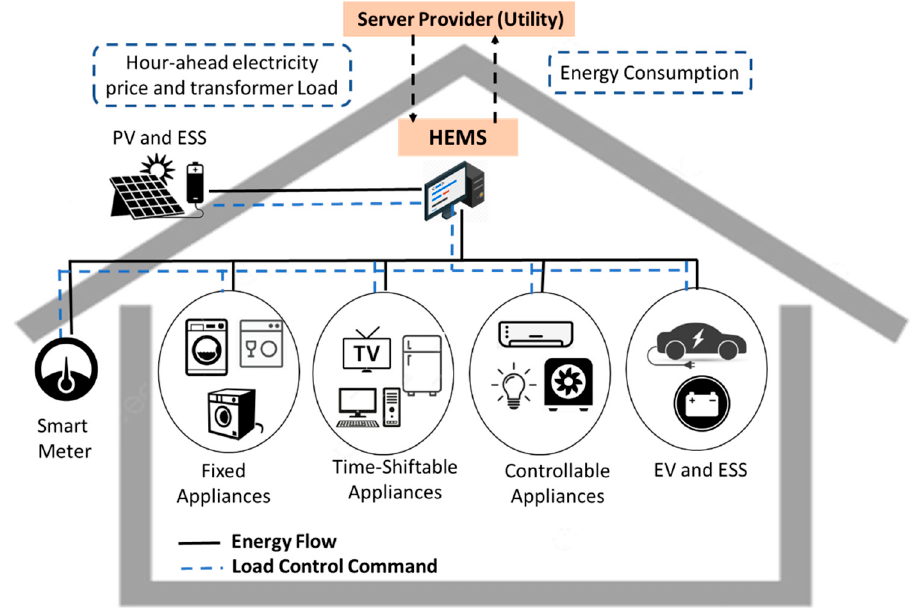
Figure 1. HEMS interfacing with different types of household appliances and assets.